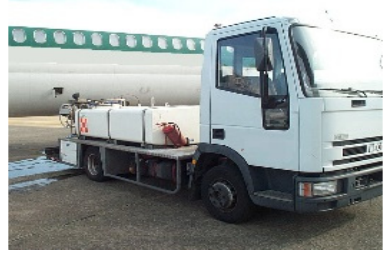
Figure 2. Aircraft potable water tank.